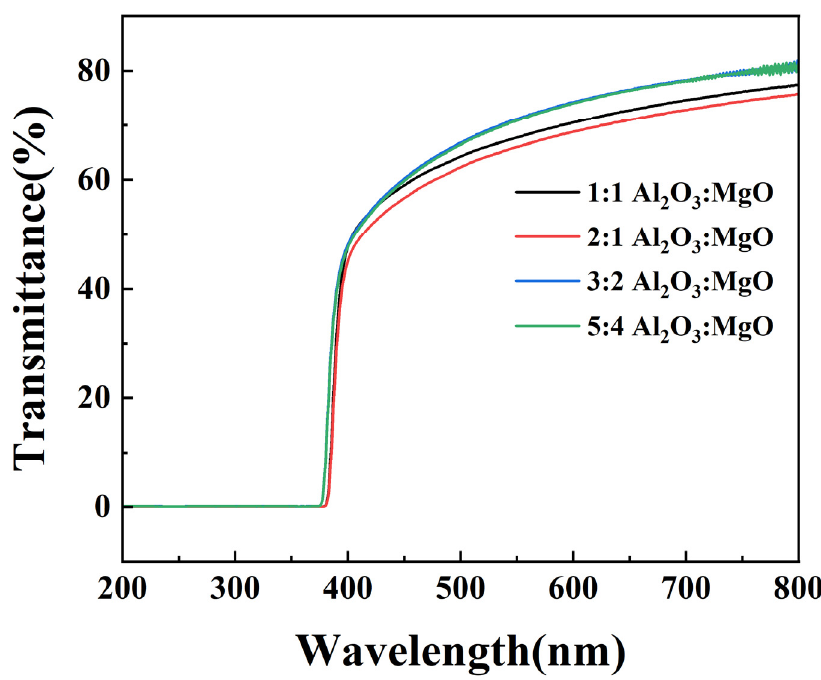
Figure 10. Visible light transmittance of Al 2 O 3 /MgO composite films with different layer alternation types and total thickness of 100 nm on PEN substrate.